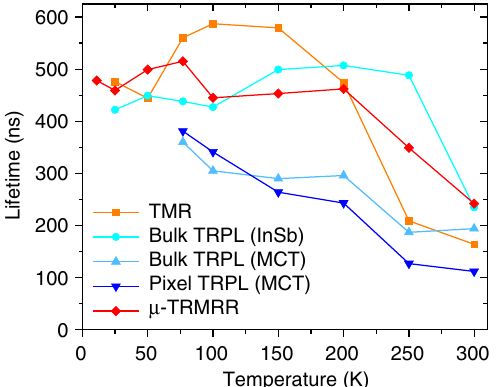
Fig. 6 Comparison of lifetime measurement techniques. Extracted carrier lifetimes as a function of temperature for time-resolved microwave re fl ectance (TMR) on as-grown InAsSb (orange), time-resolved photoluminescence (TRPL) on as-grown InAsSb using InSb (cyan) and mercury cadmium telluride (MCT) (light blue) detectors, TRPL from pixel array using MCT detector (blue), and single-pixel µ -TRMRR (red) techniques. TRPL (InSb), TMR, and μ -TRMRR agree well, but as shown, when using a less sensitive detector (such as MCT), the TRPL signal falls